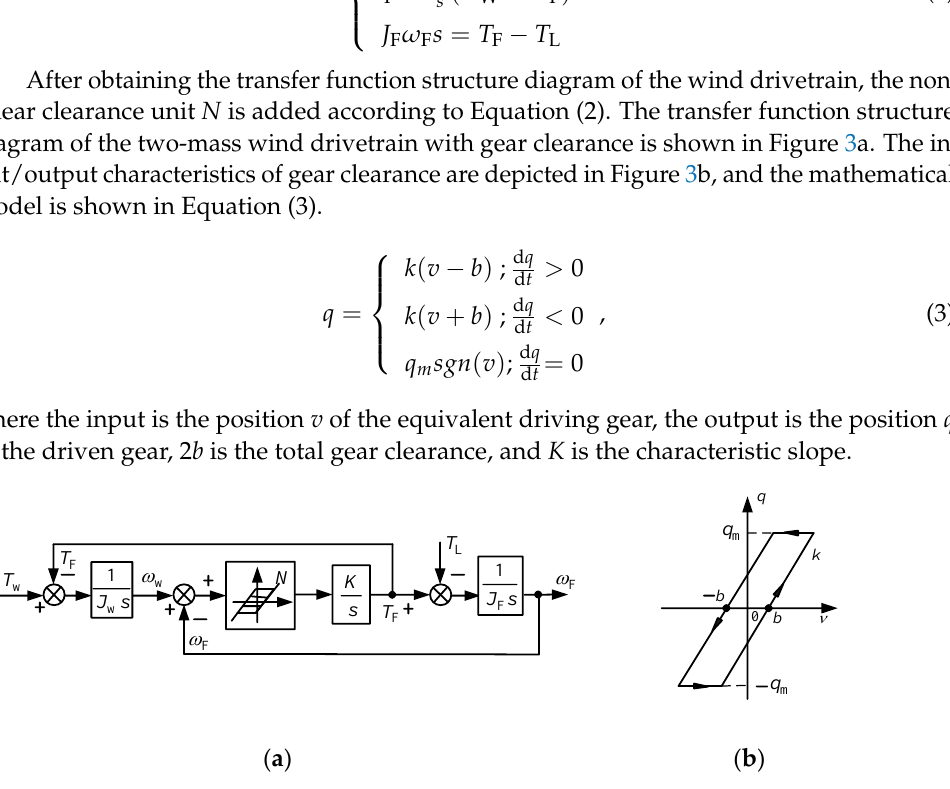
Figure 3. The transfer function structure diagram of the two-mass wind drivetrain with clearance: ( a ) the transfer function structure diagram of the two-mass wind drivetrain with clearance; ( b ) non- linear characteristics of gear clearance.